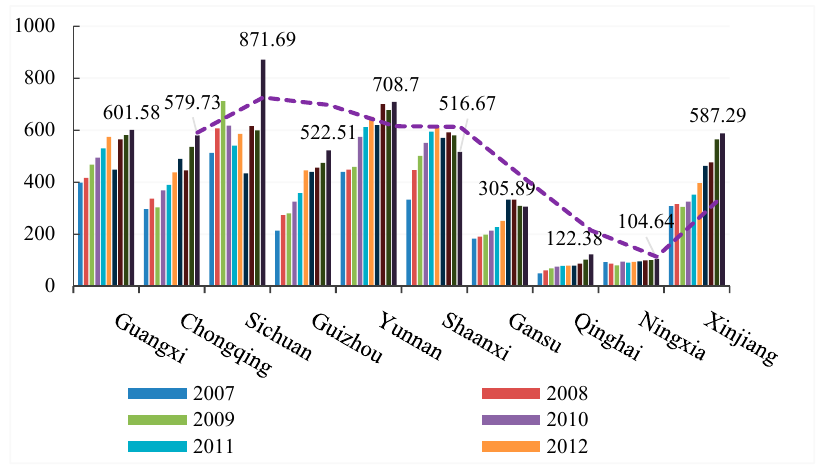
Figure 4. Transportation carbon emissions in the western region (2007–2016).